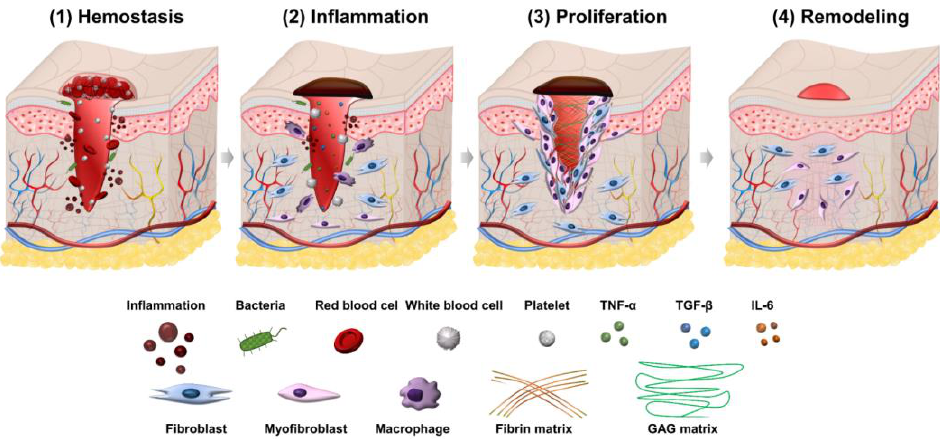
Figure 1. Illustration of four phases in the wound healing